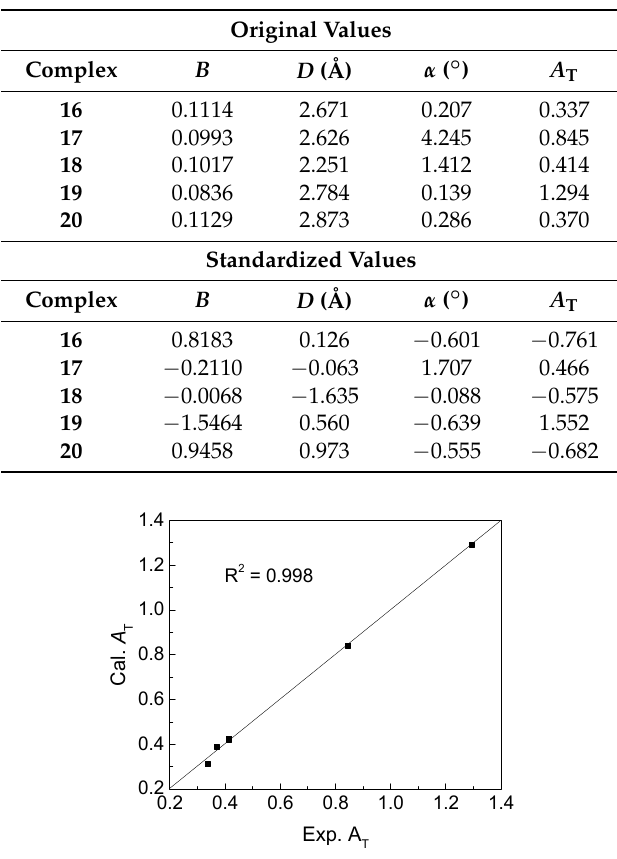
Table 6. The original and standardized values of bond order ( B ), minimum distance ( D ) and dihedral angle ( α ) along with thermal stability ( A T ) for complexes 16 – 20 , respectively.